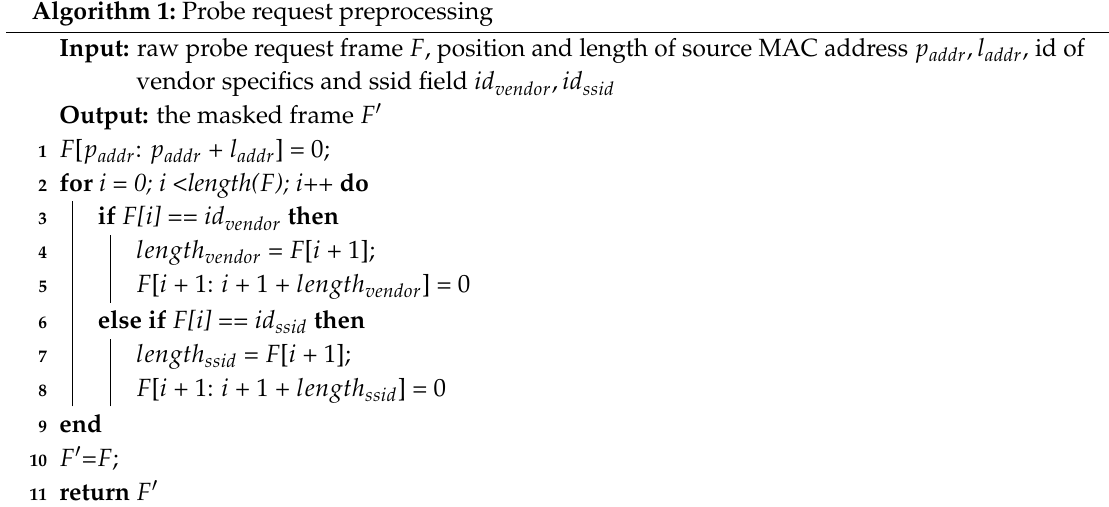
Algorithm 1: Probe request preprocessing